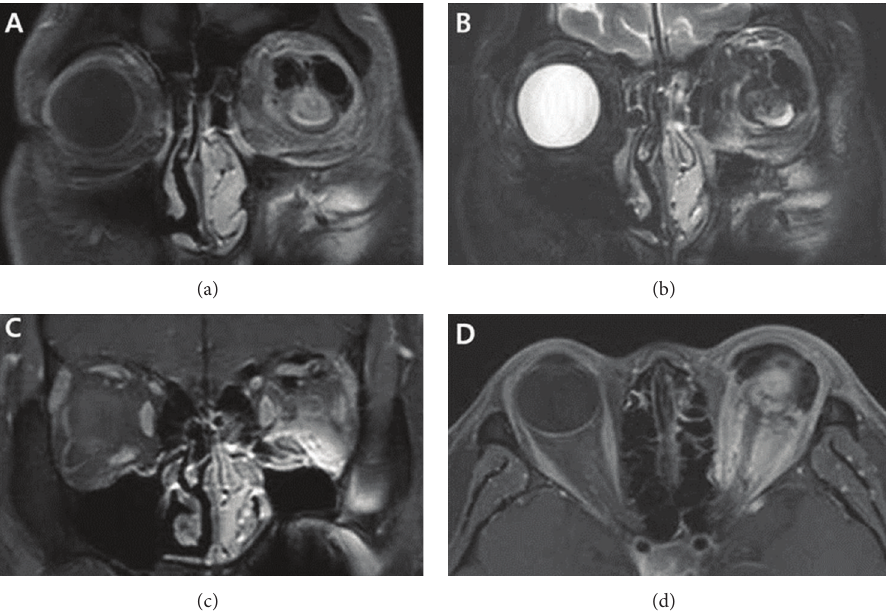
Figure 2: Magnetic resonance image (MRI). (a), (b) T1- and T2-weighted images reveal a large septate cystic mass in subconjunctival and orbital space with low signal intensity. (c), (d) The mass is located in the superior orbit accompanied by inflammatory reaction showing heterogenous enhancement in Gd-enhanced T1-weighted